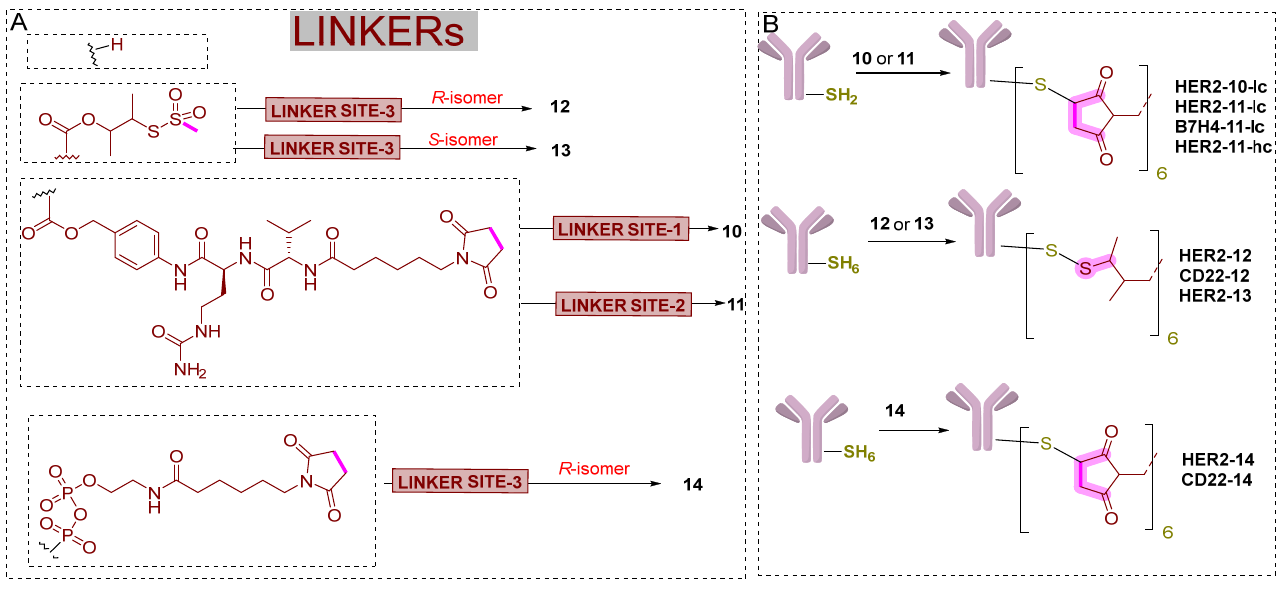
Figure 19. Linker types and conjugation strategies used for ADC designs. ( A ) Chemical structures of linkers. ( B ) Strategy illustration of linker ADC conjugation.